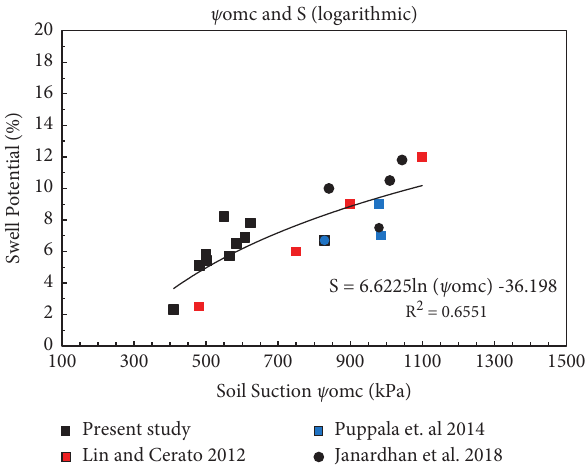
Figure 13: Demonstration of the logarithmic suction-based correlation for swell potential.